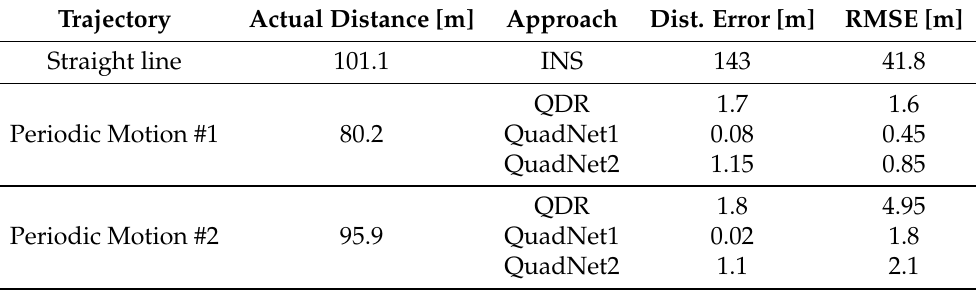
Table 1. INS, QDR, and QuadNet distance estimation errors for IMU